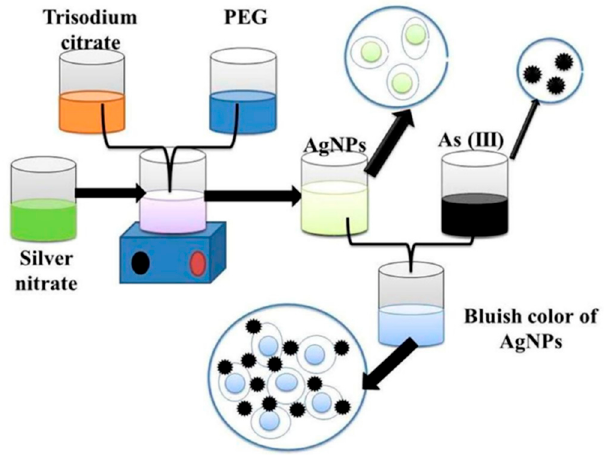
Figure 5. Functionalized silver nanoparticles as an effective medium towards trace determination of arsenic (III) in aqueous solution [40]. Copyright 2019, reproduced with permission from Elsevier B.V., Amsterdam, The Netherlands.